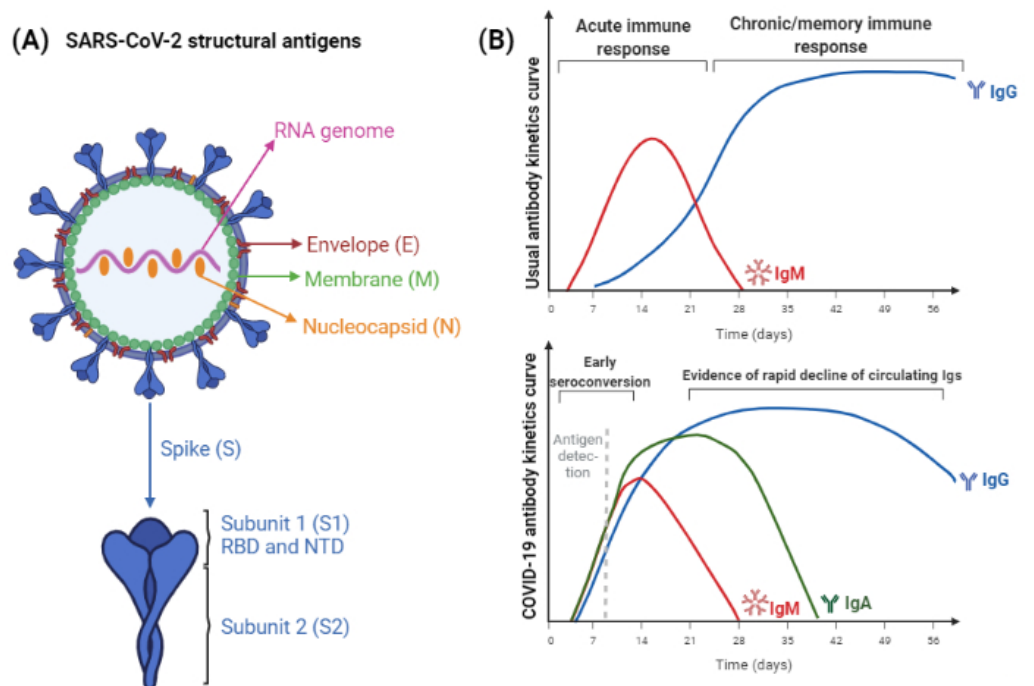
Figure 1. ( A ) SARS-CoV-2 structural antigens, used for immunoassays. Nucleocapsid and Spike proteins are the most abundant antigens, therefore, they are used for improved sensitivity. Antigen-subunits, as S1 and S2, or RBD and NTD, can provide more specific results. ( B ) The expected IgM/IgG curves following exposure to antigen through natural infection or vaccination. The maturation of immune response usually leads to initial IgM induction and, while titers of this antibody class decrease, IgG titers increase and persist for longer periods, which varies according to the pathogen considered. Below it, kinetics of SARS-CoV-2 antigens and antibodies detection is represented. Differently from the expected, titers of IgA, IgM, and IgG antibodies increase in parallel. The time to achieve seronegativity and the particularities of vaccine-induced humoral response are still being elucidated (figure created with BioRender).